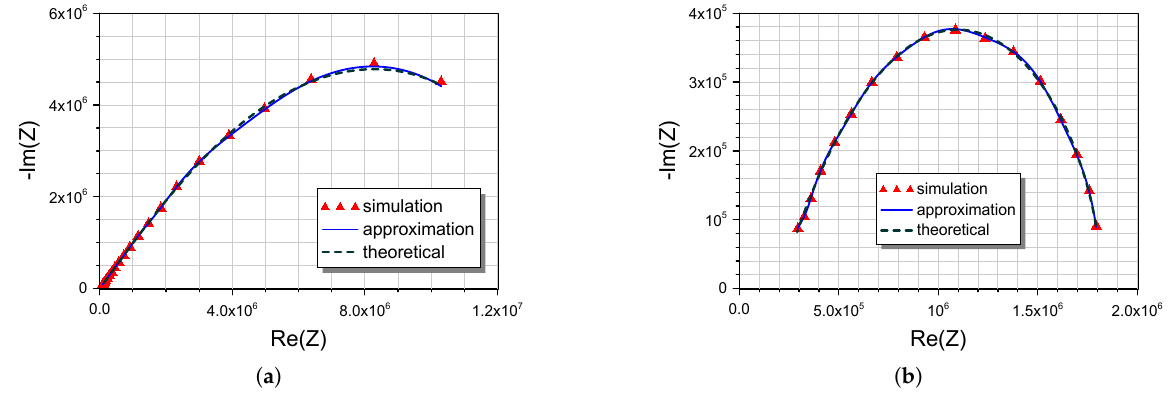
Figure 5. Nyquist plots of ( a ) the membrane and ( b ) the total tissue model of the non-infiltrated stage of the Scots Pine needles.